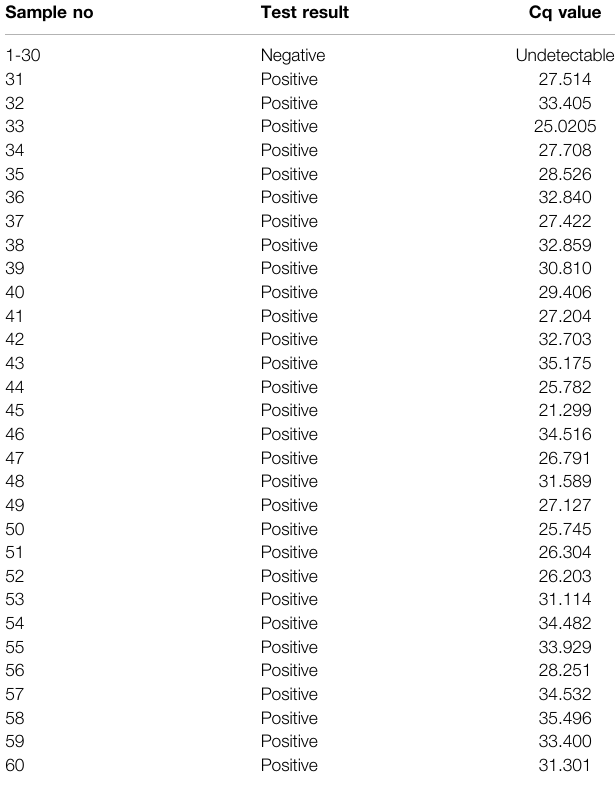
TABLE 5 | Cq values obtained from RT-QPCR for clinical nasopharyngeal